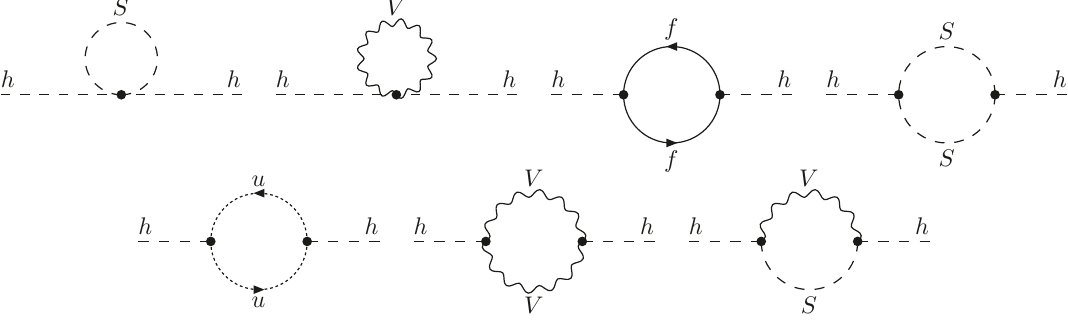
Figure 2 . Generic self-energy diagrams for the light Higgs boson h. Analogous diagrams contribute to the self-energy of the heavy Higgs boson H and to the mixing self-energy between the two